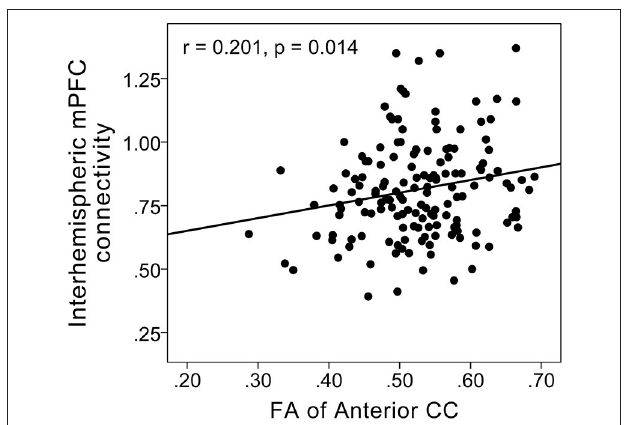
FIGURE 3 | Scatterplots showing a positive correlation between FC in the bilateral medial prefrontal cortex and fractional anisotropy of the anterior CC in MDD patients. Interhemispheric homotopic FC of the bilateral medial prefrontal cortex correlated with anterior CC microstructural integrity (r = 0.201; P = 0.014).